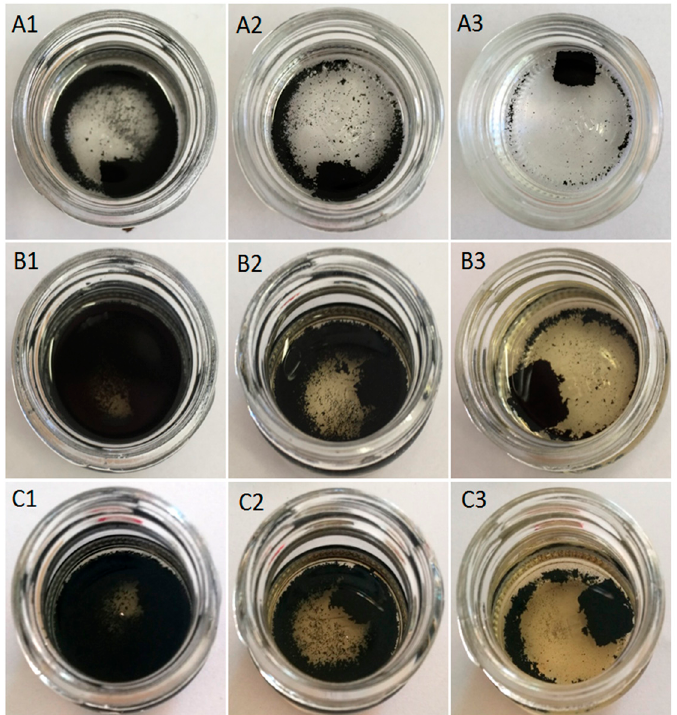
Figure 4. GTR modified with trans ‐ polyoctenamer rubber (TOR); the letters indicate the extraction time in toluene: ( A ) few minutes; ( B ) 24 h; ( C ) 72 h; the numbers indicate the temperature at which the samples were compression molded: ( 1 ) 140 °C; ( 2 ) 160 °C; ( 3 ) 180 °C.